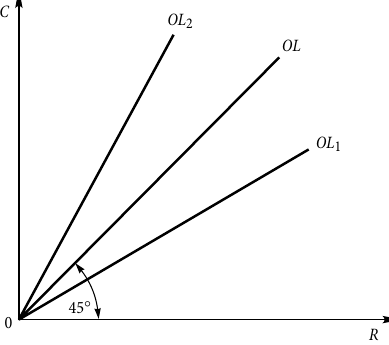
Fig. 4. Multiple phase portraits superimposed on the original phase